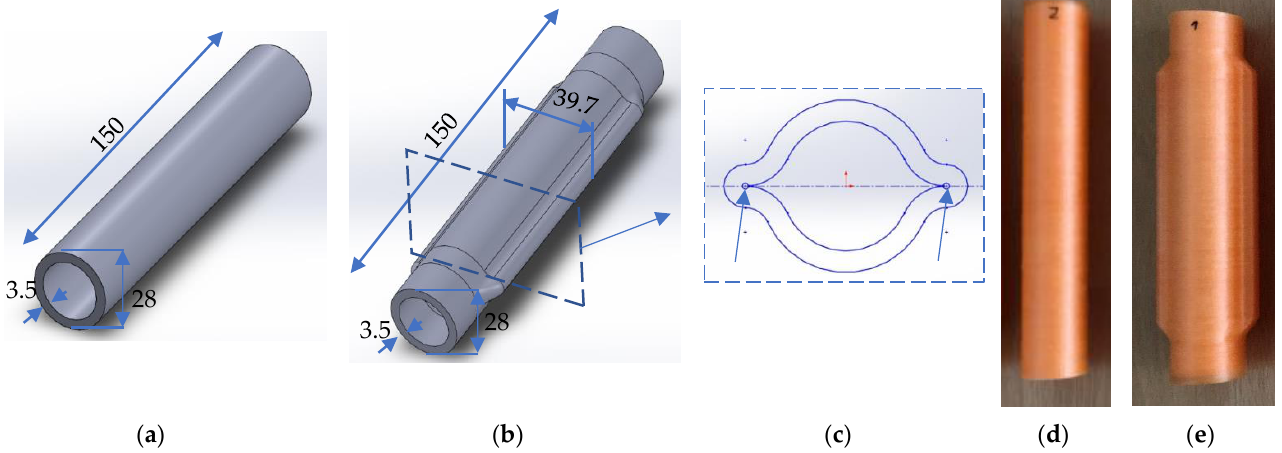
Figure 5. Geometrical details of the different designs: ( a ) Design A; ( b ) Design B; ( c ) Detail of design B; ( d ) Design A: 3D printed part; ( e ) Design B: 3D printed part. Table 2. Sample set 1 — different hose configurations for design A.